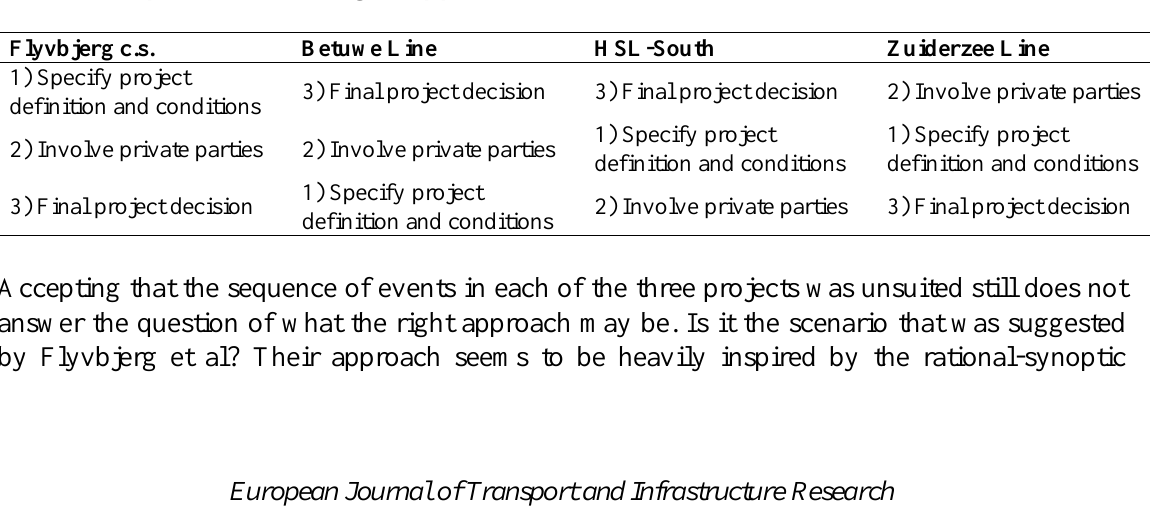
Table 2. Sequences of strategies